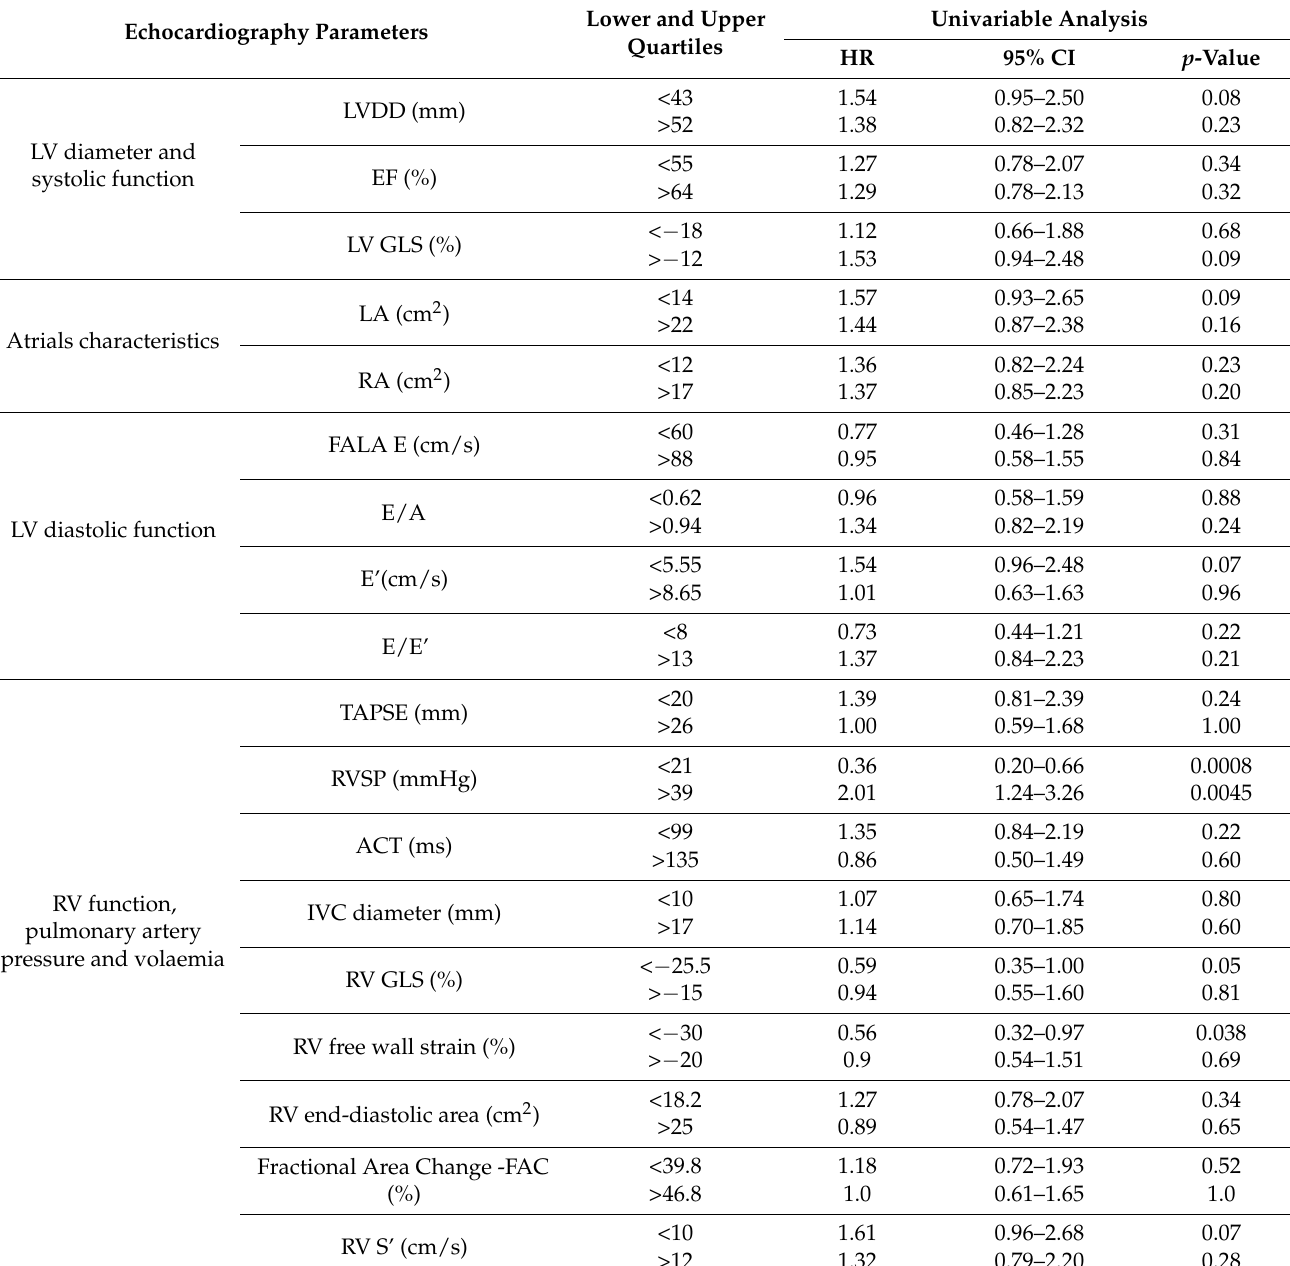
Table 4. Baseline main parameters of echocardiography as predictors of OS. Values of lower and upper quartiles were adopted as cut-off points. Univariate exploratory